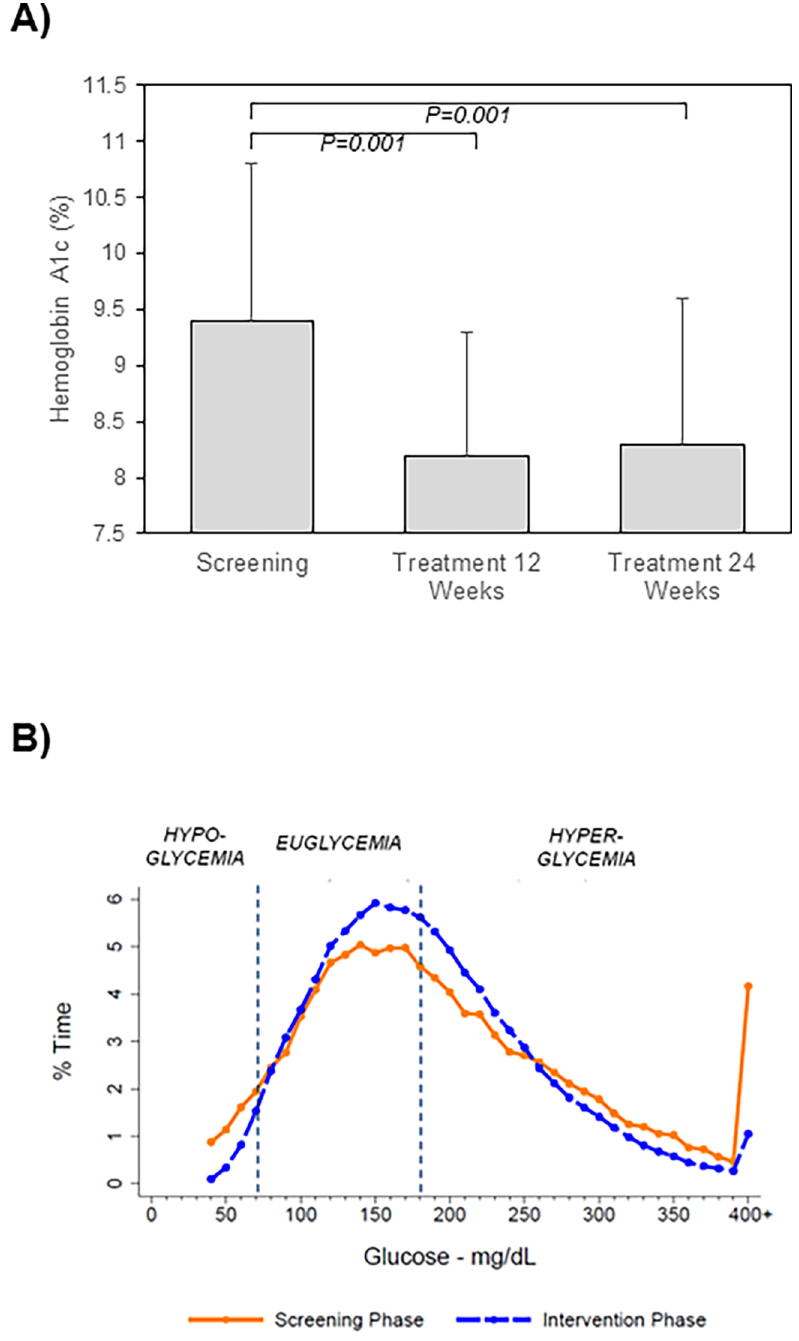
Fig 3. Effects of CSII plus CGM on glycemic parameters are shown. Treatment elicited significant reductions in hemoglobin A1c at 12 and 24 weeks of treatment compared to screening values (A). CGM readings revealed reductions in time in both hypo- and hyperglycemia with treatment at 24 weeks (blue) compared to the screening phase (orange)